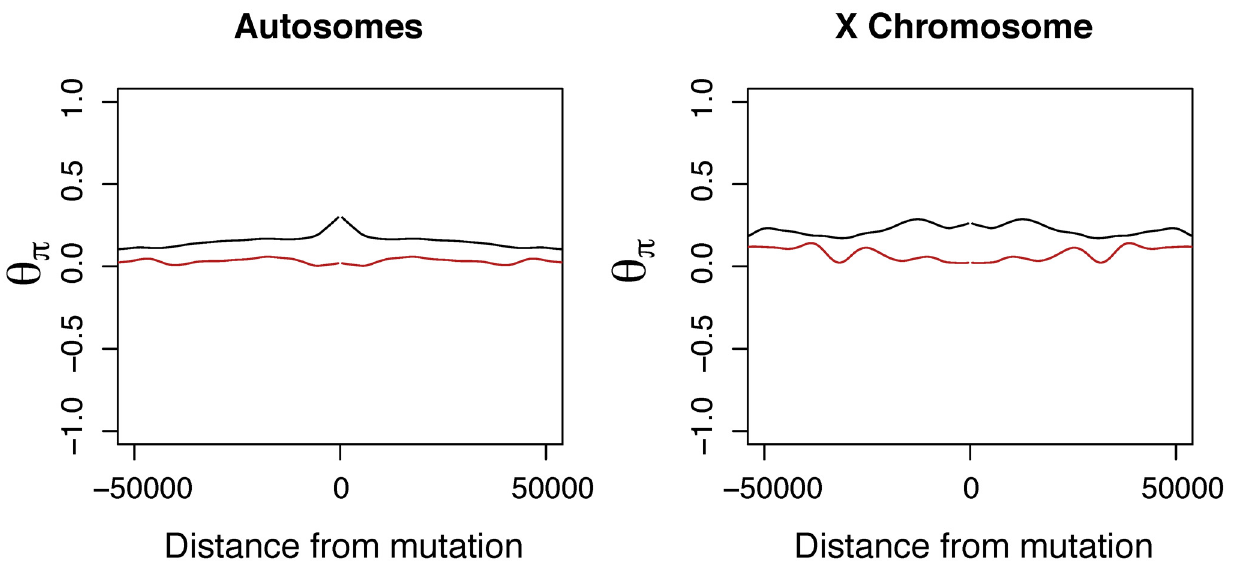
Fig 3. Nucleotide diversity, θ π as a function of distance from new mutations in D. simulans for putatively neutral intronic SNPs (black) and for tandem duplications (red) by chromosome with lowess smoothing. Duplicates show a reduction in mean diversity approaching duplications on the D. simulans autosomes and X chromosome, whereas neutral SNPs show no reduction in diversity. Plots exclude centromeric regions and the 4th chromosome which have atypical nucleotide diversity. Chromosome 3L is strongly affected by a cluster of duplications at roughly 8.5Mb, which is excluded from the plot, but the effect is still significant without this